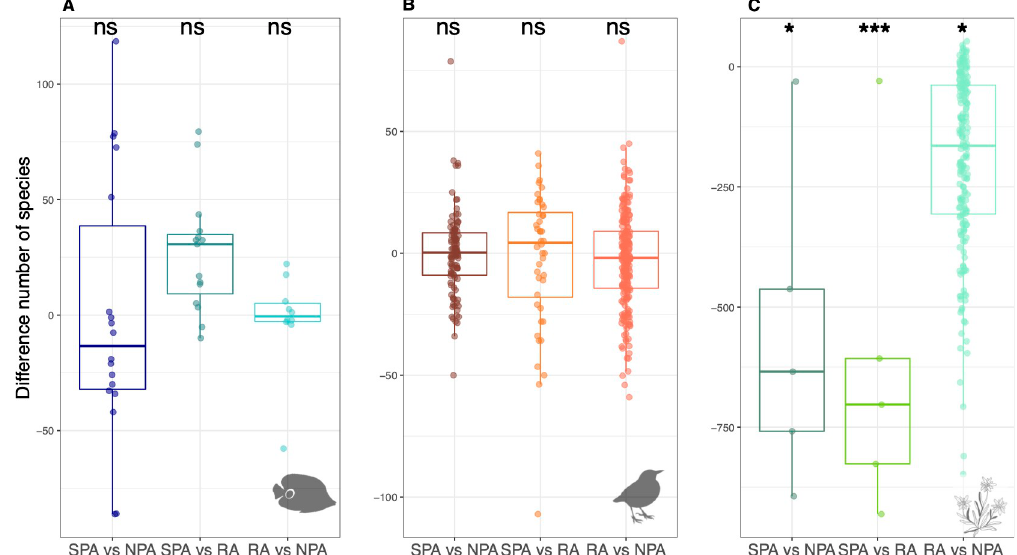
Fig 3. Pairwise comparisons of the number of species between SPA, RA, and NPA in surrounding areas within a buffer of 50 km (each dot is a protected area) for reef fishes ( A, D, G ), birds ( B, E, H ), and alpine plants ( C, F, I ). The difference in the number of species, after controlling for the number of surveys inside each protection level, is shown along with the significance of this difference (Wilcoxon): ns for p > 0.05, � for p < 0.05, �� for p < 0.01, and ��� for p < 0.001. Negative values indicate that areas with the highest protection level host less species than less protected areas. The raw data can be found in https://github.com/LoiseauN/Betadiversity-protected-areas. NPA AU : AnabbreviationlisthasbeencompiledforthoseusedinFig 3 : Pleaseverifythatallentriesarecorrect : Inaddition ; pleasedefine � ns � inFig 3 abbreviationlistifthisindeedisanabbreviation : , Non-Protected Areas; ns, non significant; RA, Restricted Areas; SPA, Strictly Protected